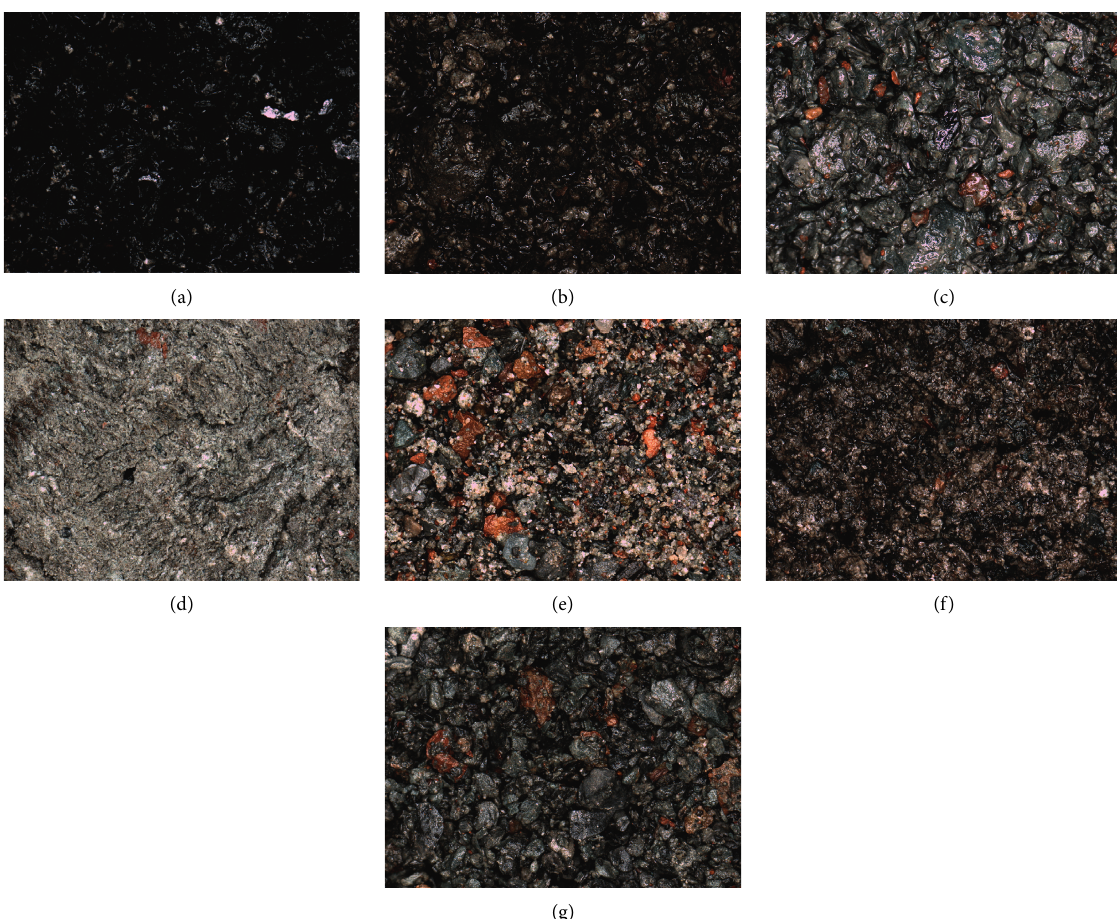
Figure 10: Seven types of rock diagrams in the dataset. (a) Black coal. (b) Gray-black mudstone. (c) Gray muddy siltstone. (d) Gray fine sandstone. (e) Light gray fine sandstone. (f) Dark gray siltstone. (g) Dark gray